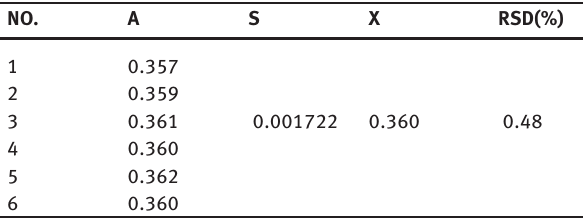
Table 2: Stability test results. (n=6).